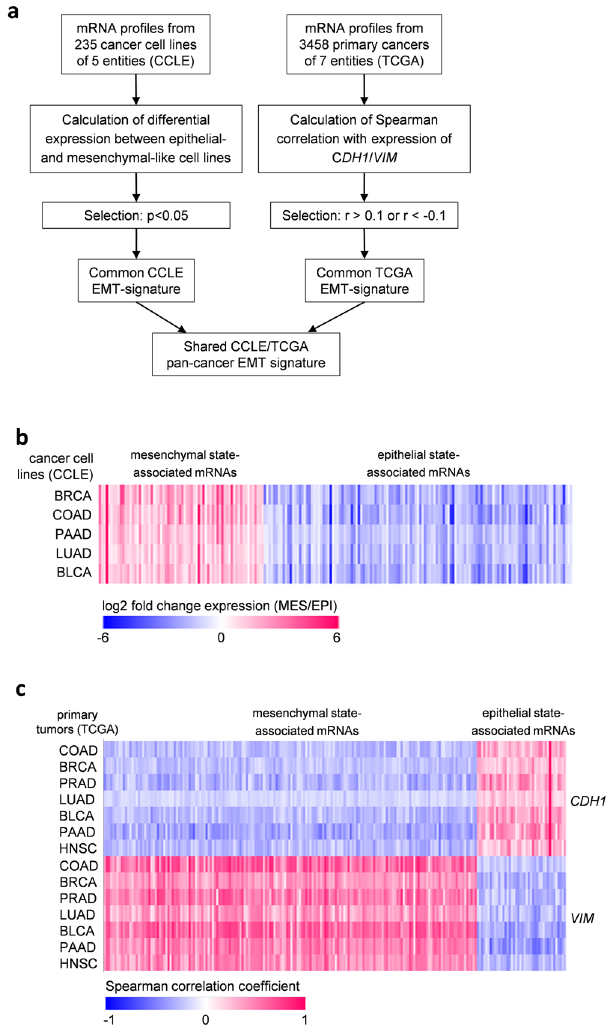
Figure 1. Bioinformatic analysis of CCLE and TCGA datasets for EMT-associated signatures. ( a ) Flow chart describing the generation of the shared pan-cancer CCLE/TCGA EMT-associated mRNA signature. ( b ) Heatmap of 201 mRNAs that showed significant differences in expression between epithelial-like and mesenchymal-like cancer cell lines within the analysed cancer entities (log2 fold change of expression is shown; p < 0.05). ( c ) Heatmap showing Spearman correlation coefficients of 365 epithelial and mesenchymal state-associated mRNAs with CDH1 and VIM . Epithelial state-associated mRNAs were defined as mRNAs that positively correlate with expression of the epithelial marker CDH1 (r > 0.1) and negatively correlate with expression of the mesenchymal marker VIM (r < − 0.1) in all indicated TCGA datasets. Mesenchymal state-associated mRNAs were defined as mRNAs that negatively correlate with expression of the epithelial marker CDH1 (r < − 0.1) and positively correlate with expression of the mesenchymal marker VIM (r > 0.1) in all indicated TCGA datasets. COAD, colon cancer; BRCA, breast cancer; LUAD, lung cancer; HNSC, head&neck squamous cel cancer; PRAD, prostate adenocarcinomas; BLCA, bladder cancer; PAAD, pancreatic